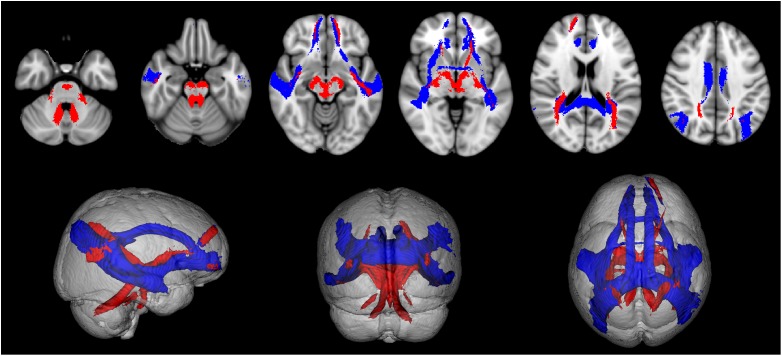
The population map of each tract is thresholded at 50% to select its most consistent part across subjects and to eliminate spurious streamlines. Here are shown all 32 resulting tract masks in MNI 1 mm standard space. These tract masks were subsequently registered to MS patients to compute tract-averaged diffusion FA. Tracts connecting cerebral nodes are displayed in blue, while cortico-cerebellar connections are displayed in red.